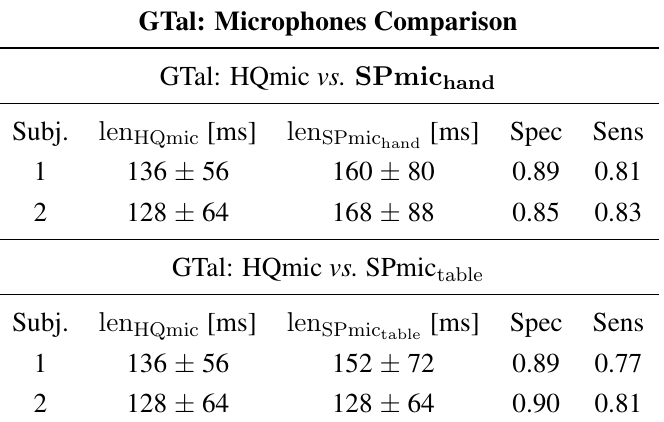
Table 1. GTal, microphones comparison: segment lengths (median ± MAD), specificity (Spec) and sensitivity (Sens) estimated from the different concurrent audio samples. Spec and Sens are defined with respect to voiced segments as identified on the high quality microphone (HQmic).